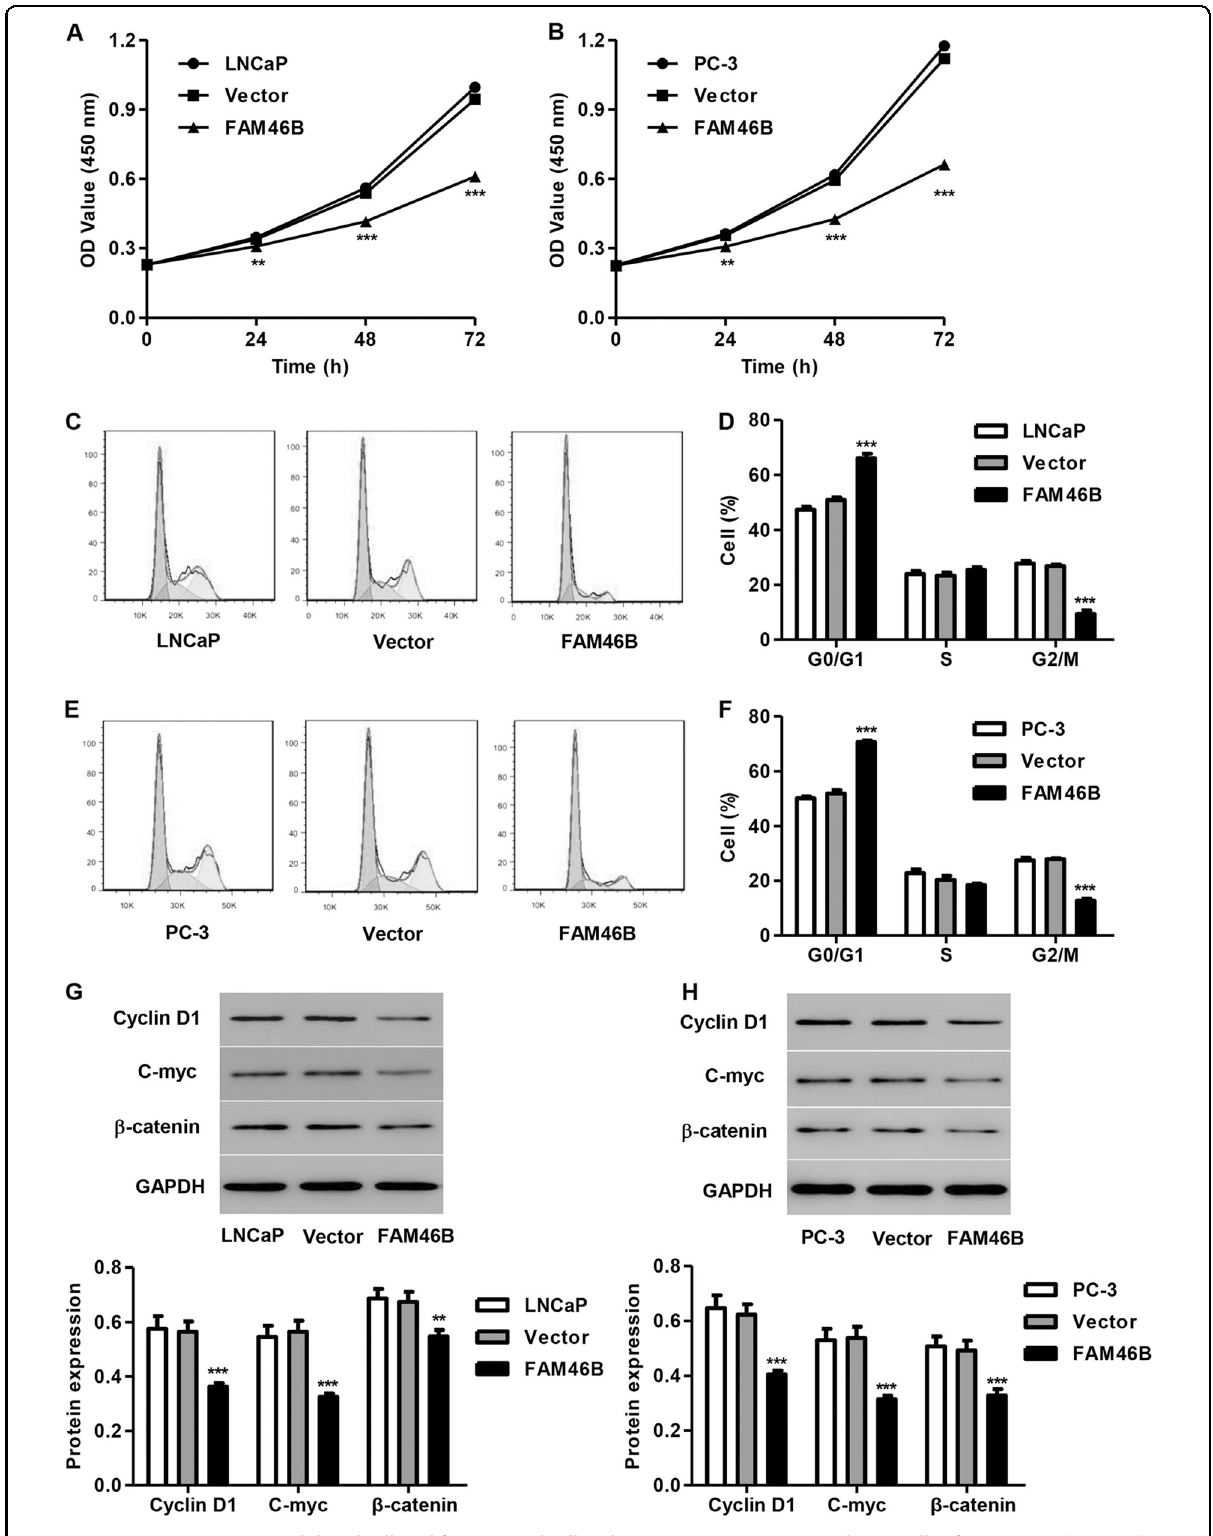
Fig. 4 FAM46B overexpression inhibited cell proliferation and cell cycle progression in LNCaP and PC-3 cells After LNCaP and PC-3 cells were transfected with pLVX-Puro-FAM46B, cell proliferation, cell cycle progression and the expression of C-myc, Cyclin D1, and β -catenin were measured by CCK-8 assay a , b , fl ow cytometry c – f , and western blotting g , h , respectively. ** P < 0.01, *** P < 0.001 compared with blank